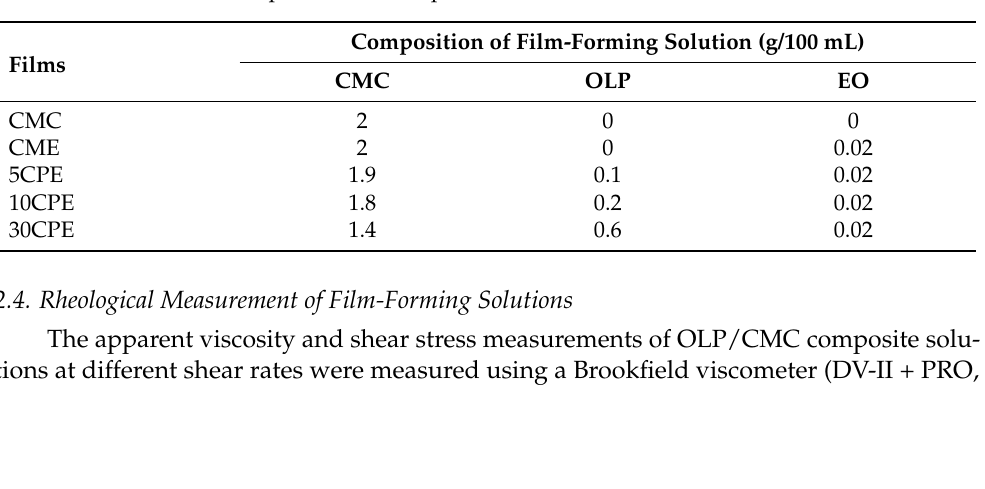
Table 1. OLP/CMC biocomposite films